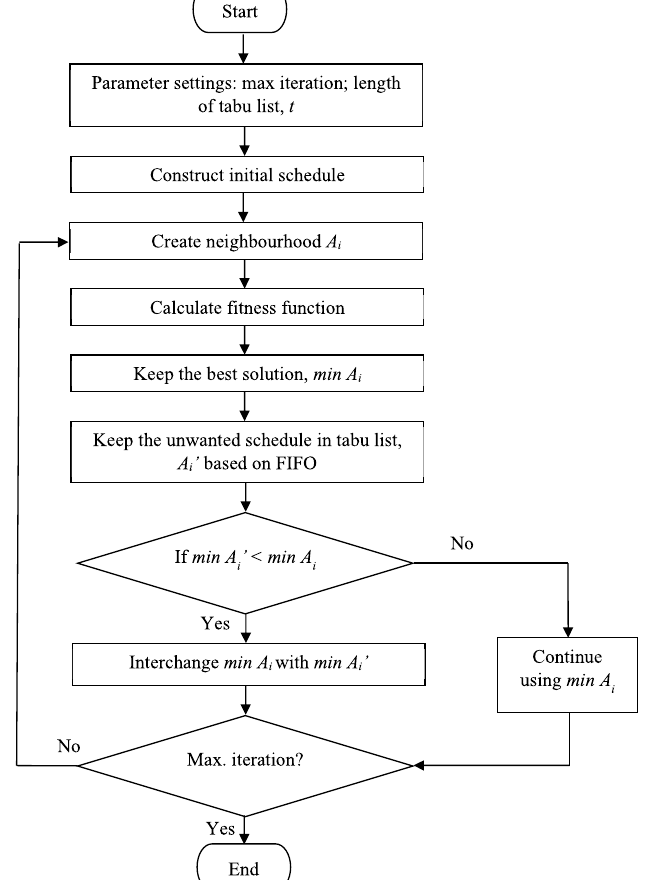
Figure 6. The proposed tabu search algorithm for nurse rostering